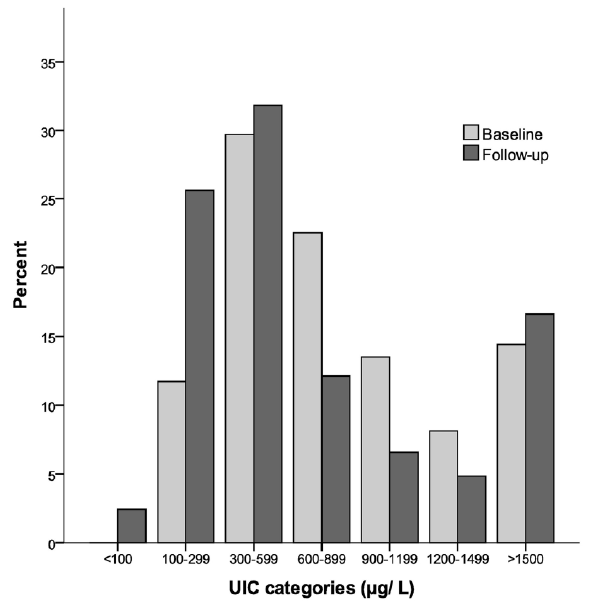
Figure 2. Percentage distribution of children’s UIC at follow-up ( n = 289) and UIC at baseline ( n = 111) according to different categories of iodine status